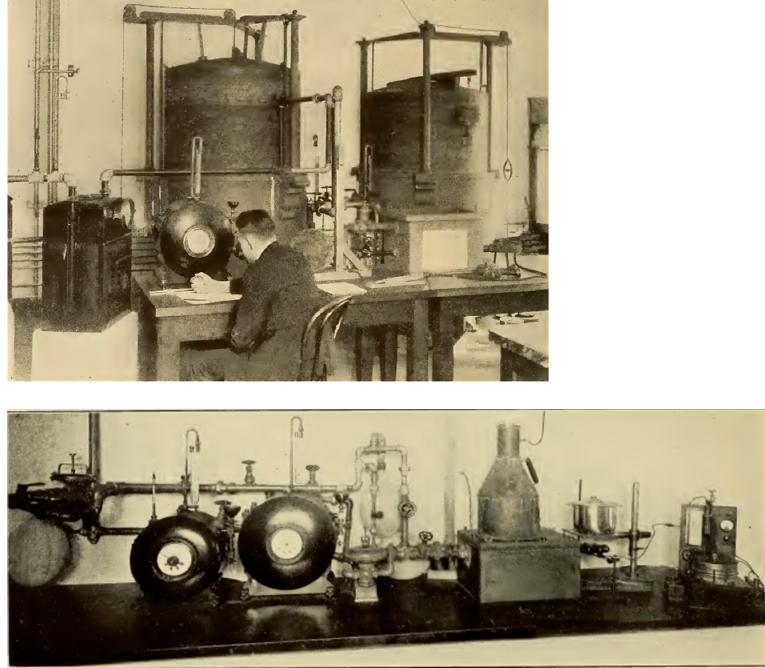
Figure 7. Apparatus setup for studying burner performance at the Bureau of Standards of the U.S. in the 1920s